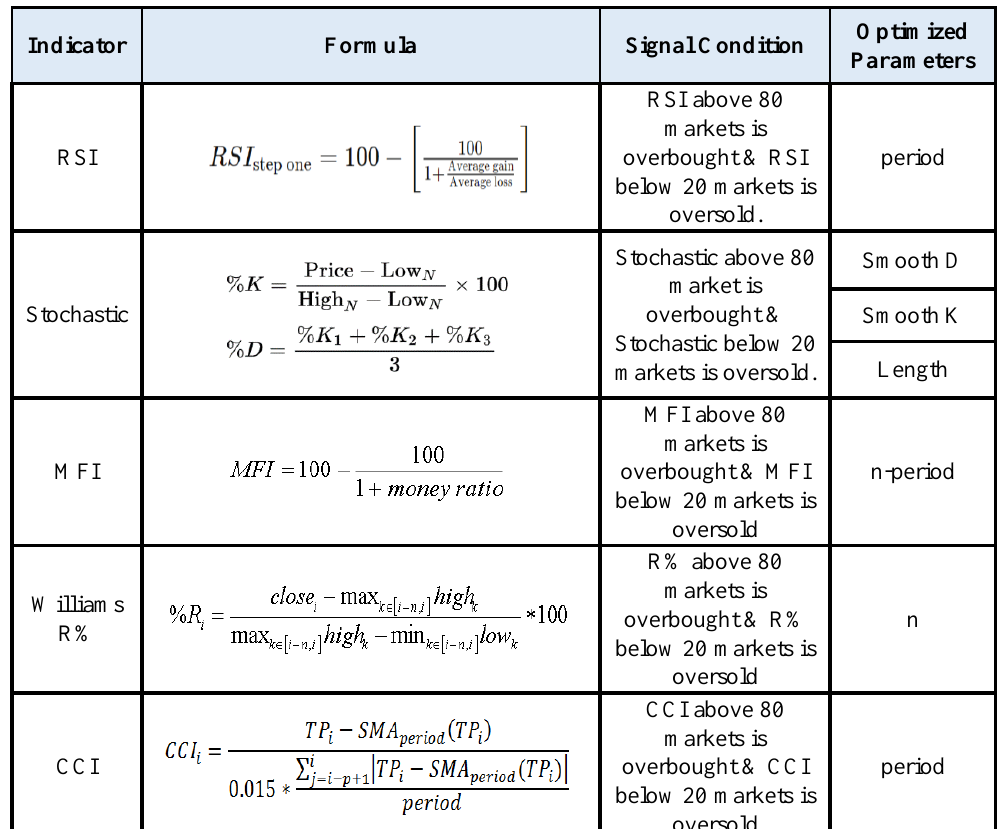
Table 2. Indicators lists have been used in non-trending